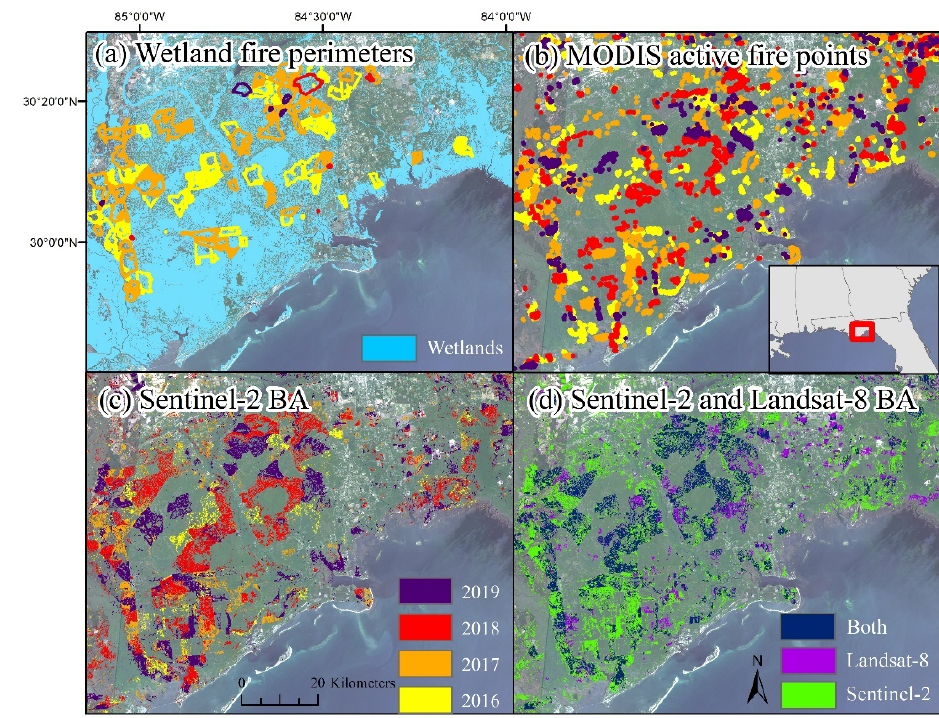
Figure 7. ( a ) Compiled wetland burn perimeters, ( b ) MODIS active burn points, ( c ) burned area mapped using Sentinel-2 by year, and ( d ) the Landsat-8 Burned Area Product and the Sentinel-2 burned area. Legend colors in ( c ) apply to ( a , b ) as well. Wetlands in ( a ) represent National Wetland Inventory data, including estuarine and marine wetland, as well as freshwater emergent, shrub, and forested wetlands. Base imagery was from Landsat-8 collected on 27 April 2019 and 14 March 2018. Table 5. The distribution of the reference burn perimeters by size class and wetland type, and the number and percent of the reference burn perimeters mapped as burned by the Sentinel-2 (S2) burned area. Pal. = palustrine. Wetland Size (ha) Burn Perimeter Count (% of